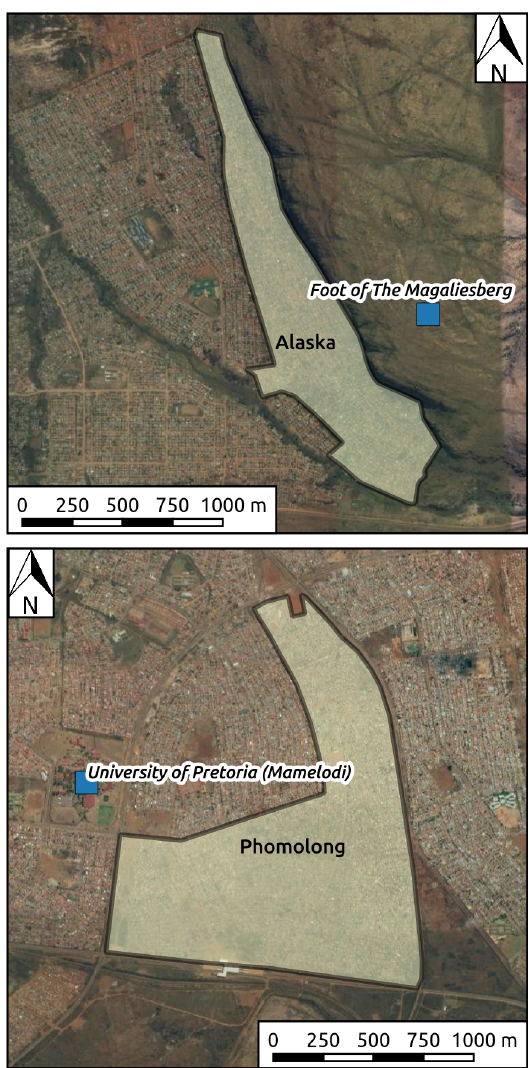
Figure 2. Top: Alaska (top) and Phomolong (bottom)